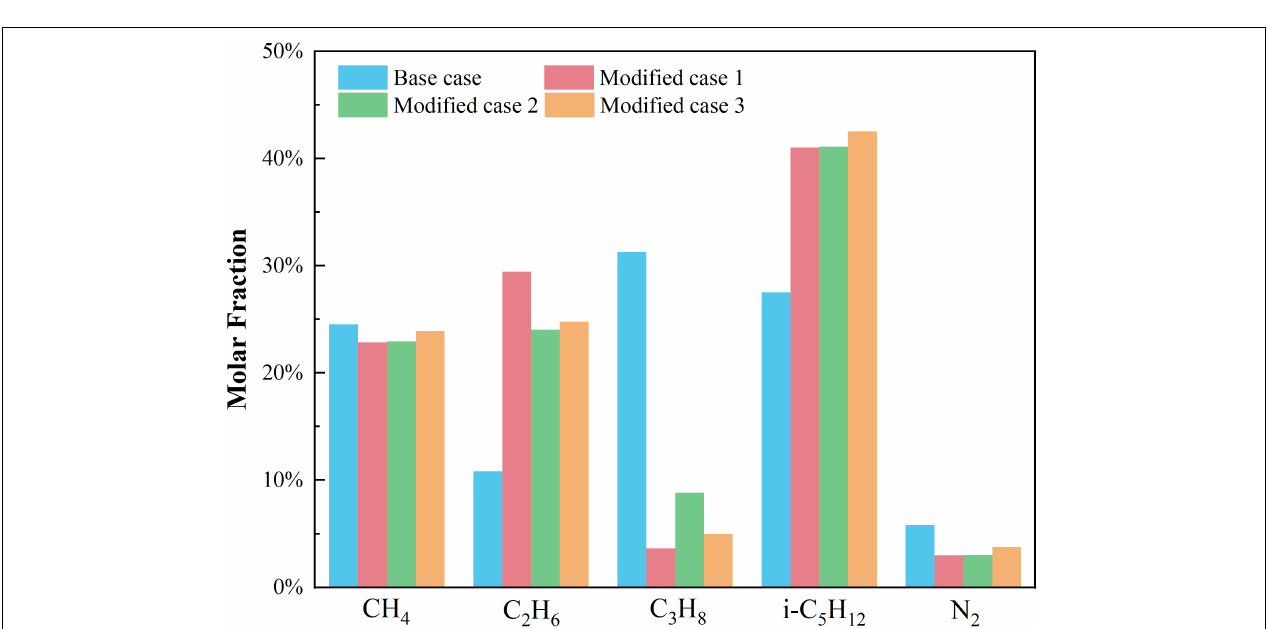
FIGURE 4 | The optimal MR molar fractions of four